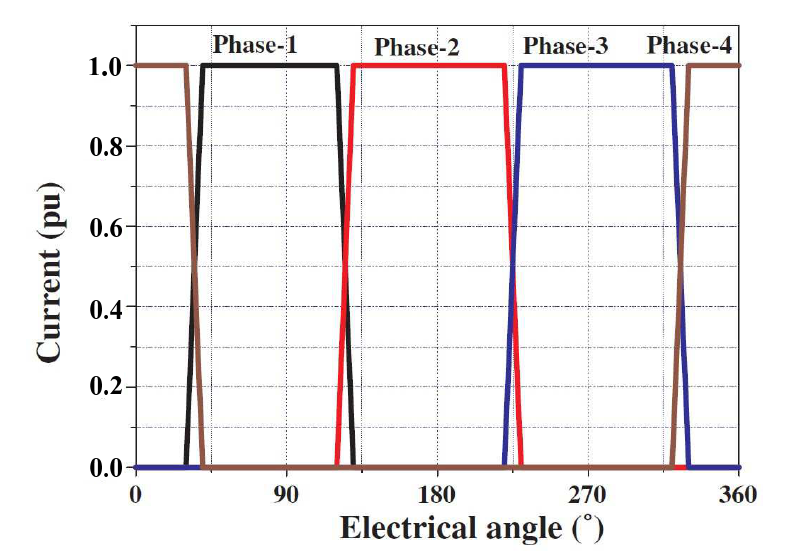
Figure 3. Current supply strategy of studied machines. Thus, when the teeth of stator slots of a given phase’s statoric pole are aligned with the teeth of the rotor, the position is designated as conjunction position (in this position, the flux created by the magnets in the phase coils reach a maximum value, Figure 4).